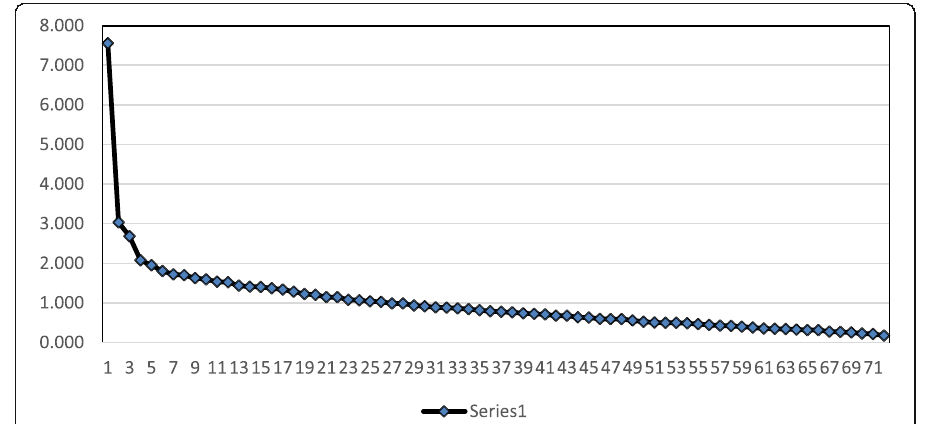
Fig. 1 The distribution of the extracted